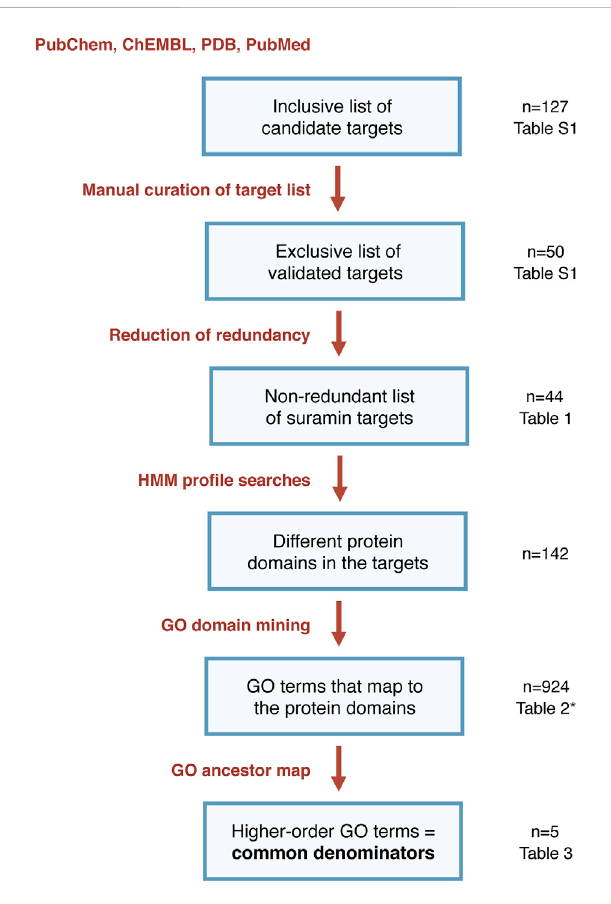
FIGURE 1 Flowchart of the bioinformatic pipeline from published proteins to common denominators of suramin targets (*note that Table 2 does not showallthe924identi fi edGOtermsbutonlythosethatwereassociated to at least fi ve different suramin target